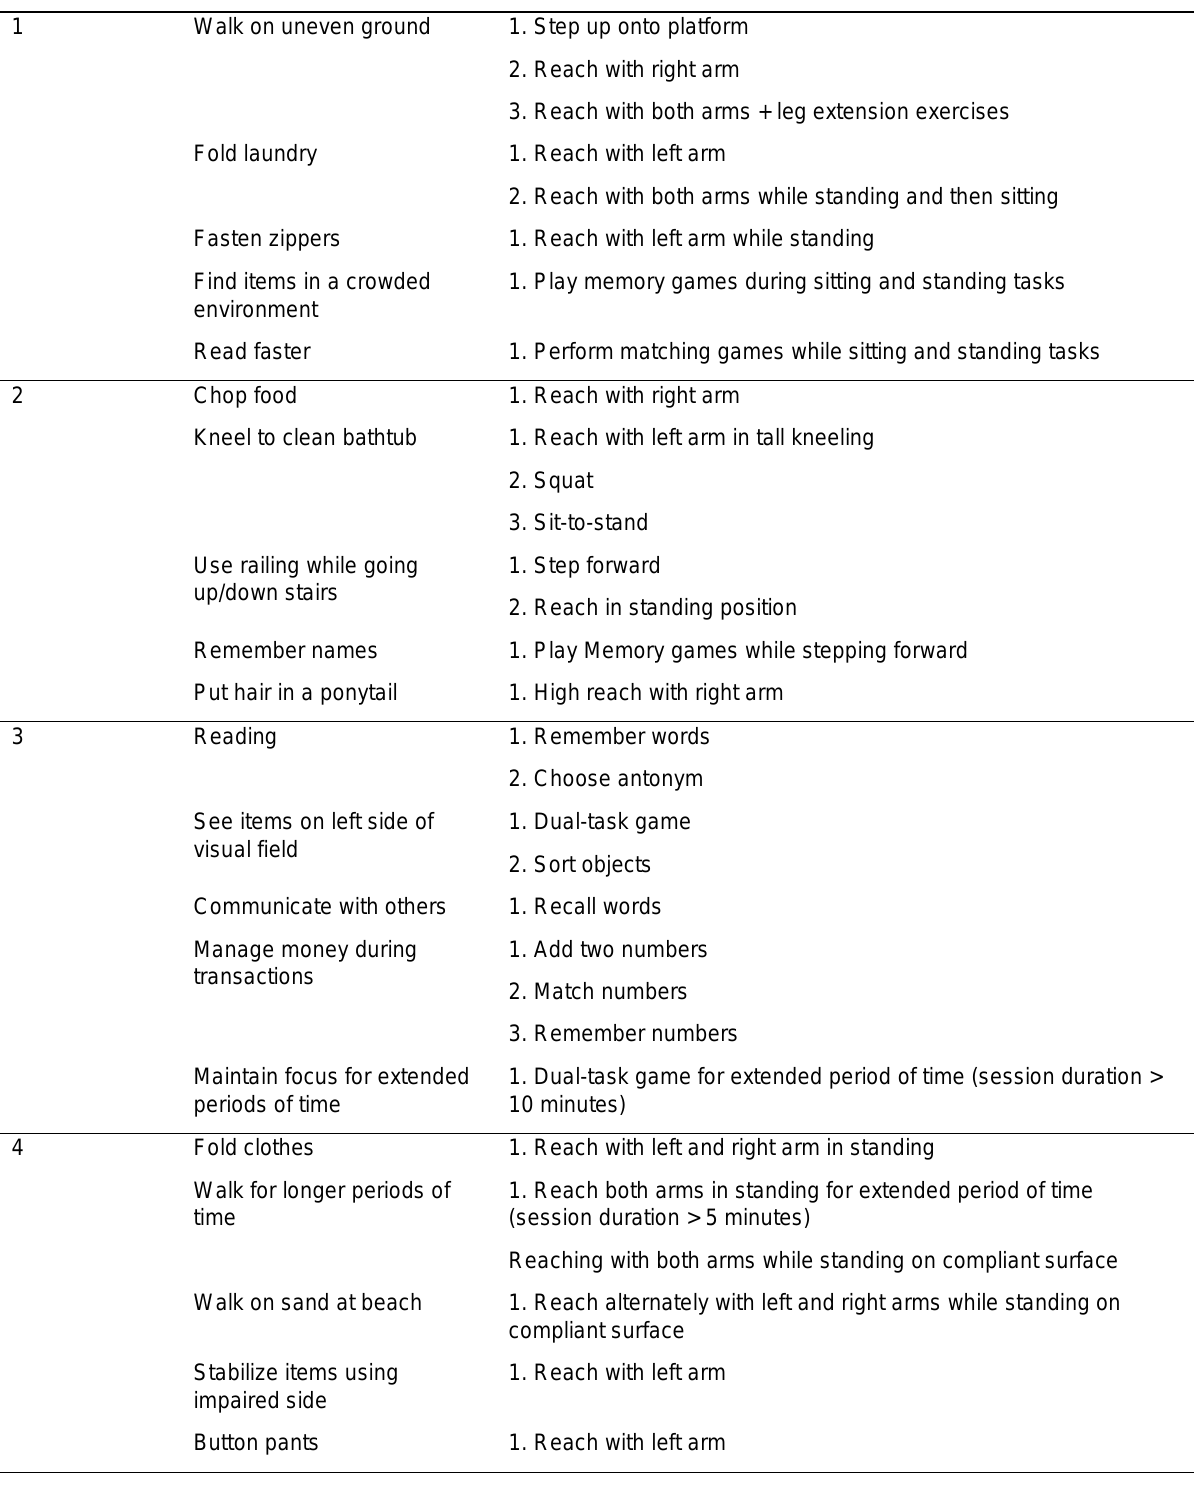
Table 2. Canadian Occupational Performance Measure (COPM) Goals and Associated Game Sessions for Each Participant Participant COPM Goal Game Session